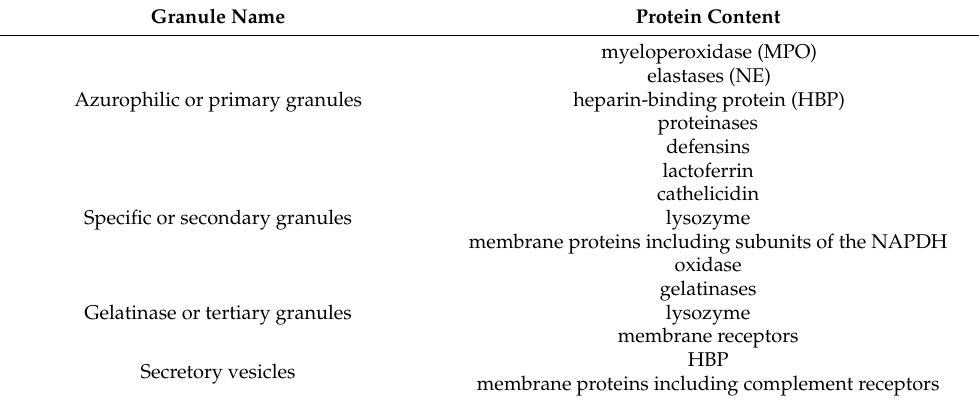
Table 1. Granules and their protein